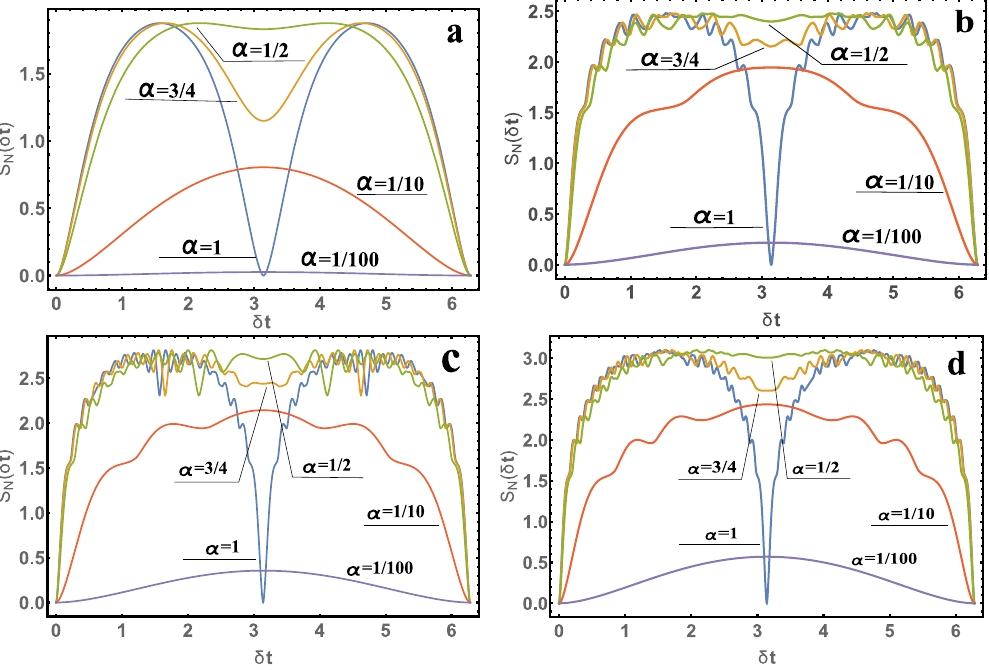
Figure 2. The results of calculating the Von Neumann entropy S N = S N ( δ t ) for α = (1, 3/4, 1/2, 1/10, 1/100) and ( a ) s 1 = 0, s 2 = 10; ( b ) s 1 = 5, s 2 = 10; ( c ) s 1 = 10, s 2 = 10; ( d ) s 1 = 20, s 2 =